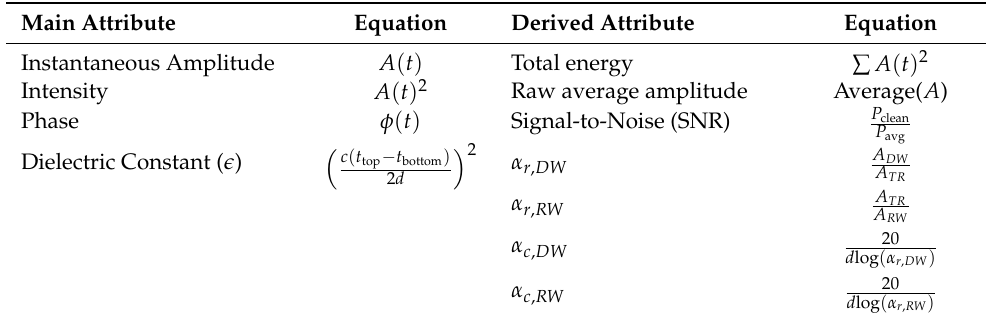
Table 1. Attribute calculation for GPR scans. The attributes are based on a Hilbert transform. Here, c = speed of light, d = depth of concrete, t top = travel time top reflection, t bottom = travel time bottom reflection, α r = attenuation ratio, α c = attenuation constant, DW = direct wave, RW = reflected wave, TR = top reflected